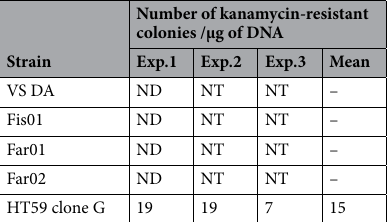
Table 1. Efficiency of transformation of human serum sensitive- B. garinii strains with pBSV2. ND not detected, NT not tested.